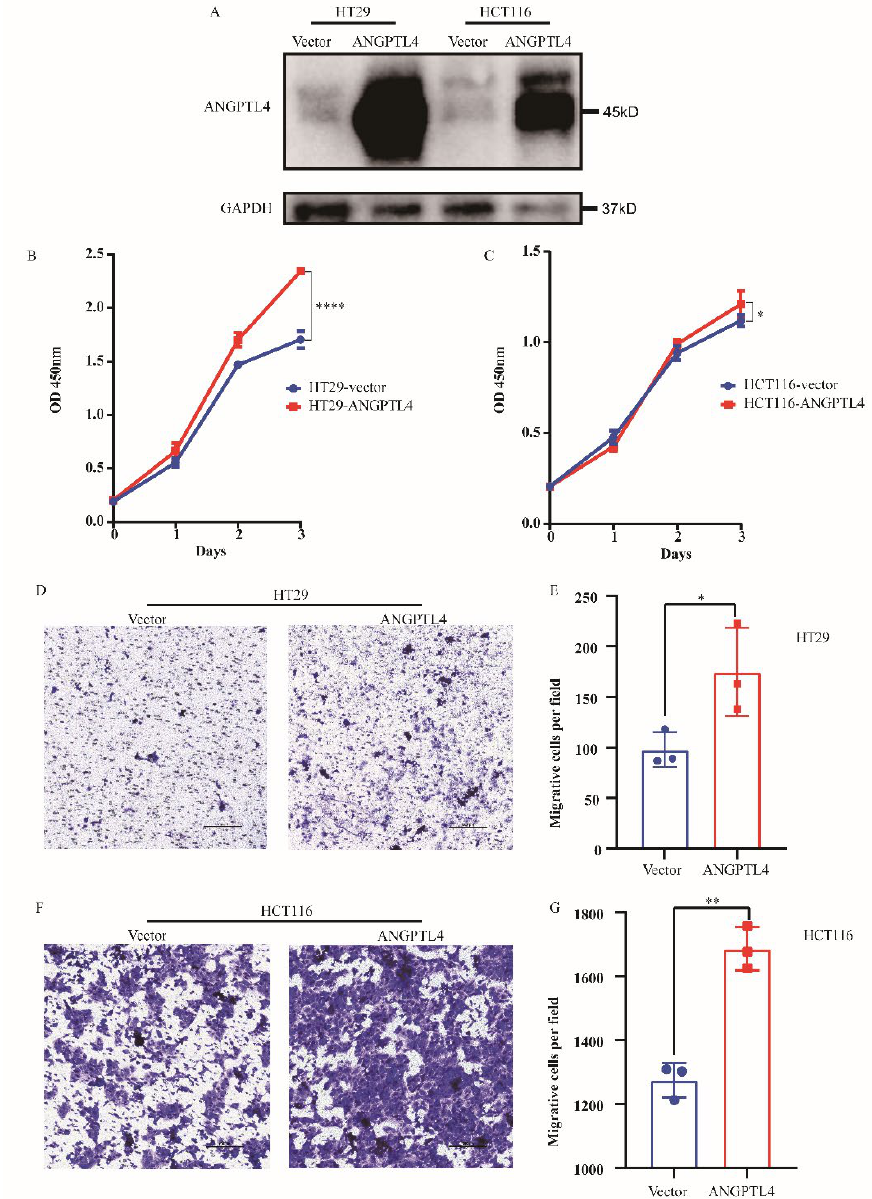
Figure 7. ANGPTLs4 promotes the proliferation and migration of CRC cells. ( A ) The protein level of ANGPTLs4 in HT29 cells and HCT116 cells after ANGPTLs4 overexpression. ( B , C ) The proliferation ability of HT29 and HCT116 cells measured by CCK8 assays. ( D – G ) The migration ability of HT29 and HCT116 cells measured by transwell migration assays. * represent p < 0.05; ** represent p < 0.01; **** represent p < 0.0001.